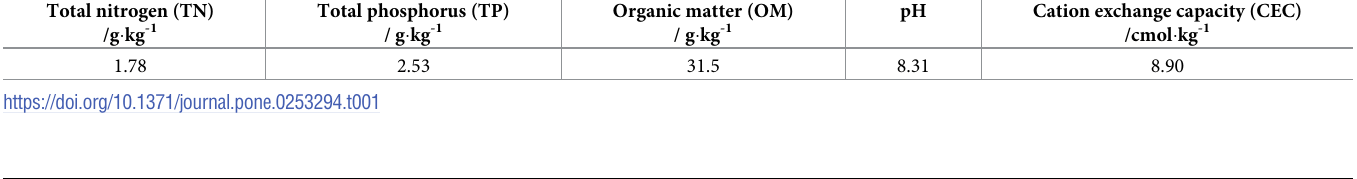
Table 1. The physical chemical properties of the soil. Total nitrogen (TN) /g � kg